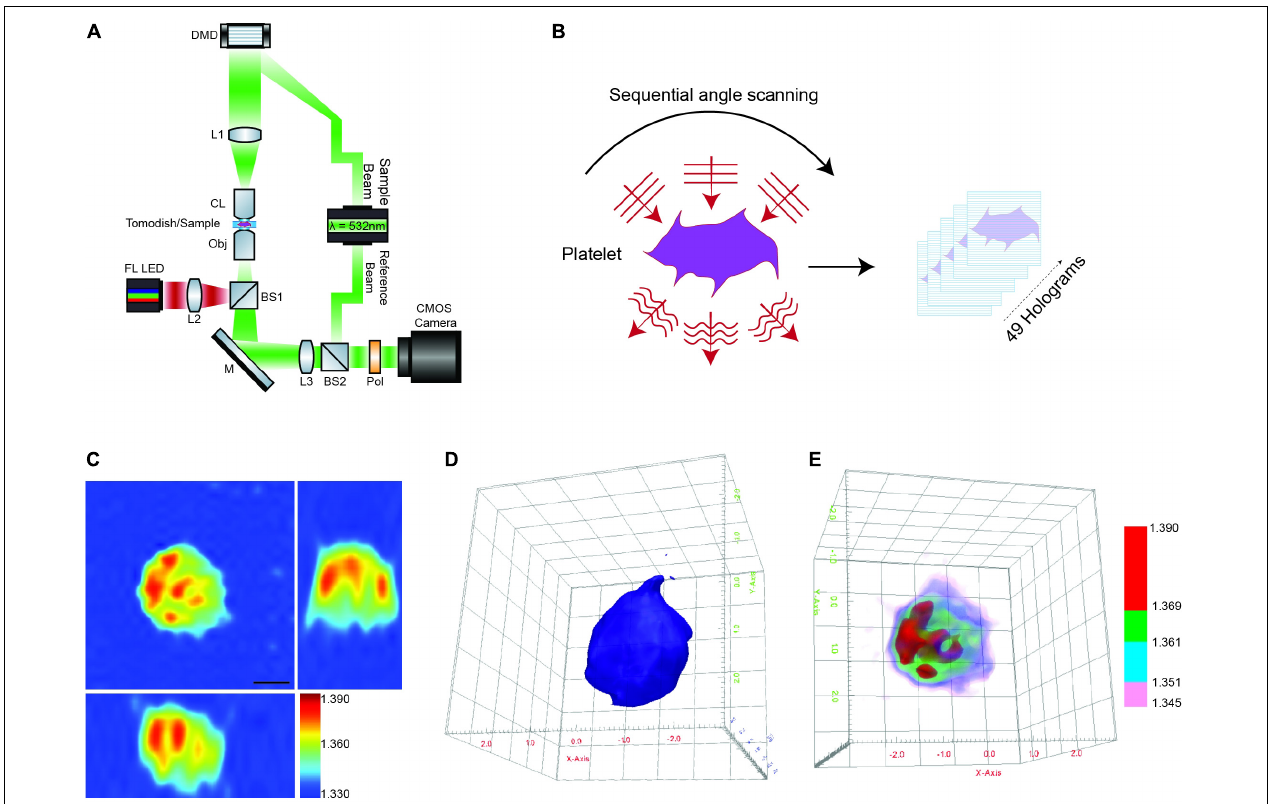
FIGURE 1 | Label-free 3D ODT imaging of platelets. (A) Simplified schematic of a holotomographic microscope based on Mach-Zehnder interferometric microscopy. λ -532 nm, laser light source; DMD, digital micromirror device; L1–L3, lenses; CL, condenser lens 60 × NA 1.2; Obj, objective lens 60 × NA 1.2; M, mirror; BS1-2, beam splitter; Pol, polarizer; FL LED, fluorescence light source. (B) Image acquisition/scanning of the sample based on sequential imaging at multiple angles to yield a total of 49 holograms. (C) Representative cross-sectional 3D RI tomogram image of a platelet. Color bar represents refractive index. (D) Example of 3D surface rendering of the platelet sample used to measure morphological parameters (see also Supplementary Video 1A ). (E) Representative RI based rendering, where the pseudo coloring represents different bands of refractive index to highlight intracellular features of the platelet (see also Supplementary Video 1B ).